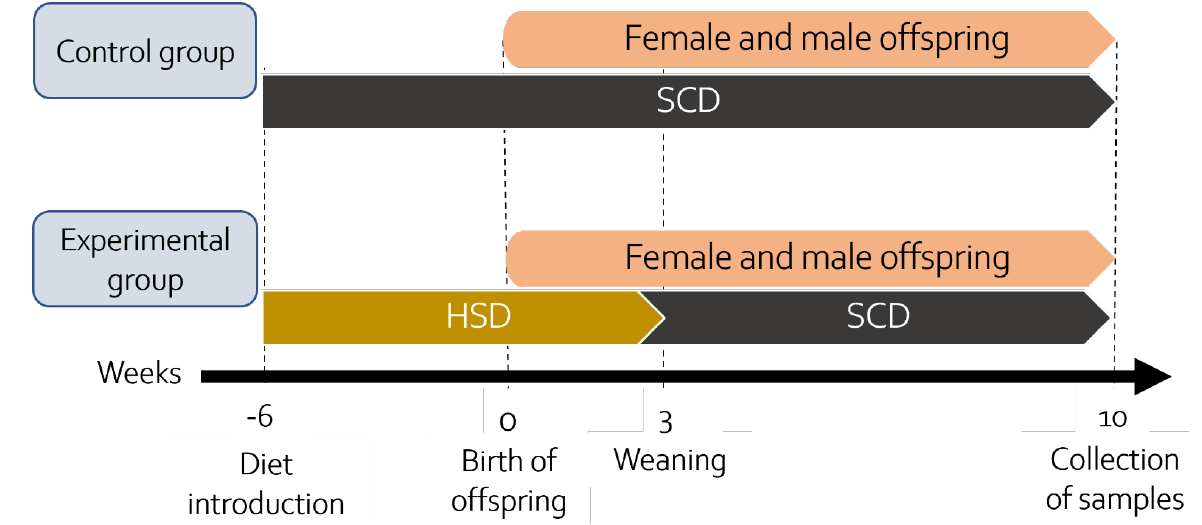
Figure 2. Graphic scheme of the experiment.